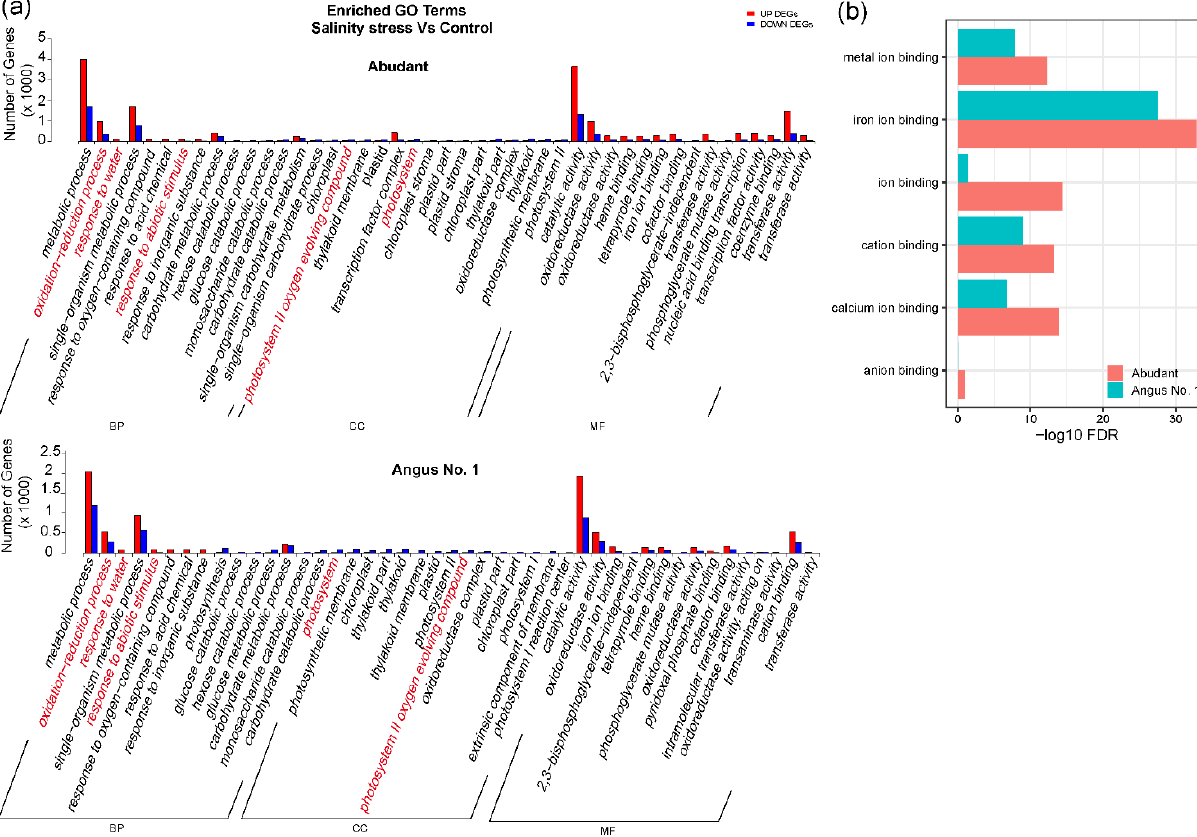
Figure 6. Gene Ontology enrichment analysis of differentially expressed genes; ( a ) bar plot of Gene Ontology enrichments for cultivar Abundant (top panel) and Angus No. 1 (bottom panel) for Up and Down DEGs respectively; and ( b ) comparison of ion binding related GO terms between cultivars under salinity stress.